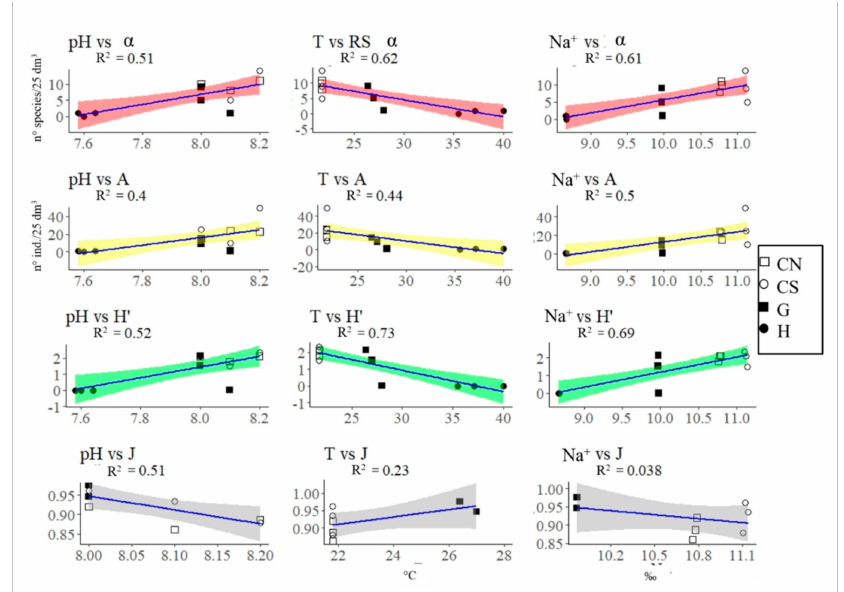
Figure 7. Linear regression models between environmental parameters (independent variables) and synecological indices (dependent variable) of Crustacea assemblages. In red—relations among environmental variables and α -diversity ( α ); in yellow—relations among environmental variables and abundances (A); in green—relations among environmental variables and diversity index (H’); in grey—relations among environmental variables and evenness (J). Significant R 2 is also shown for each